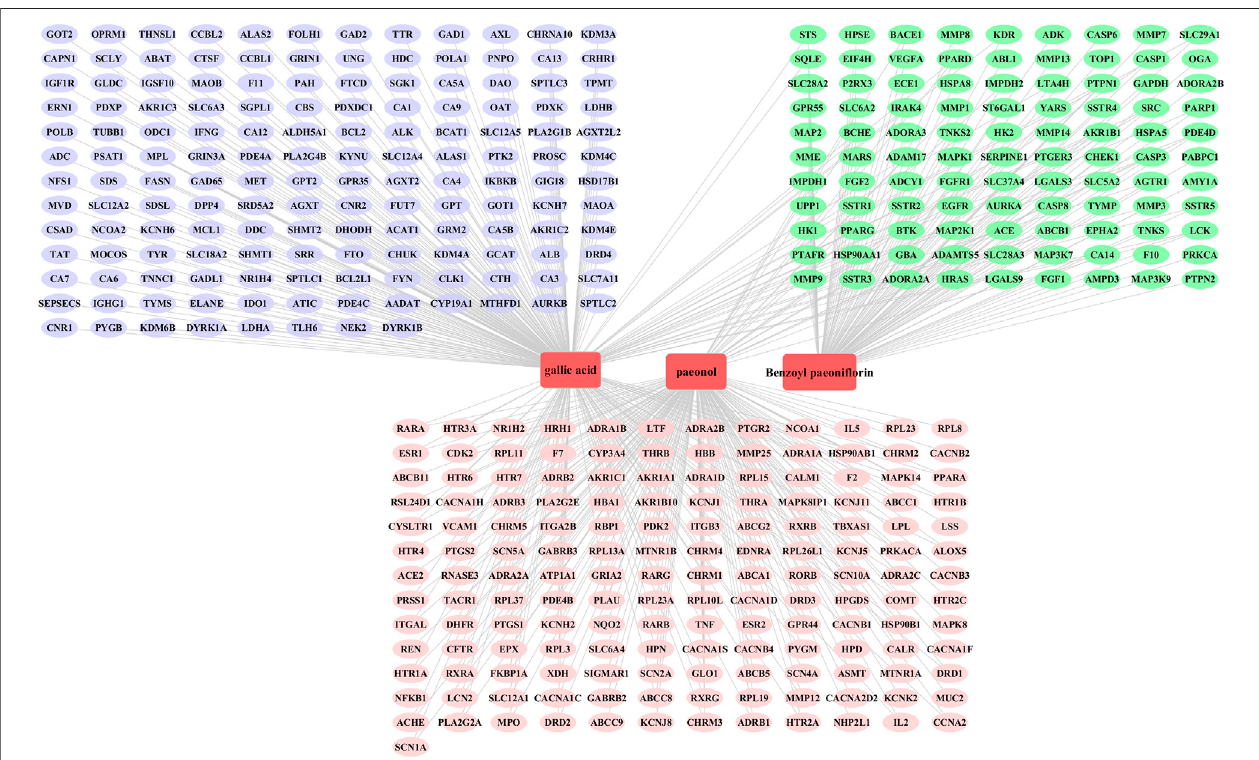
FIGURE 3 | Compound-putative target network of gallic acid, benzoylpaeoni fl orin and paeonol. Light blue circles, light green circles and light red circles represent the targets of compounds gallic acid, benzoylpaeoni fl orin and paeonol, representatively. The yellow square frames represent the compounds.